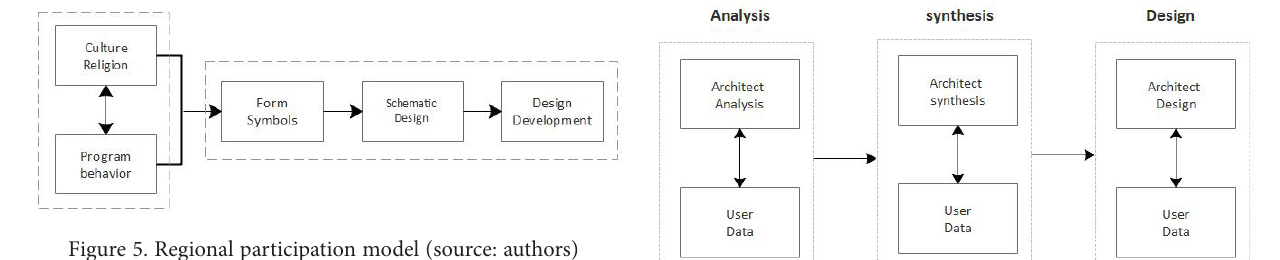
Figure 5. Regional participation model (source: authors)